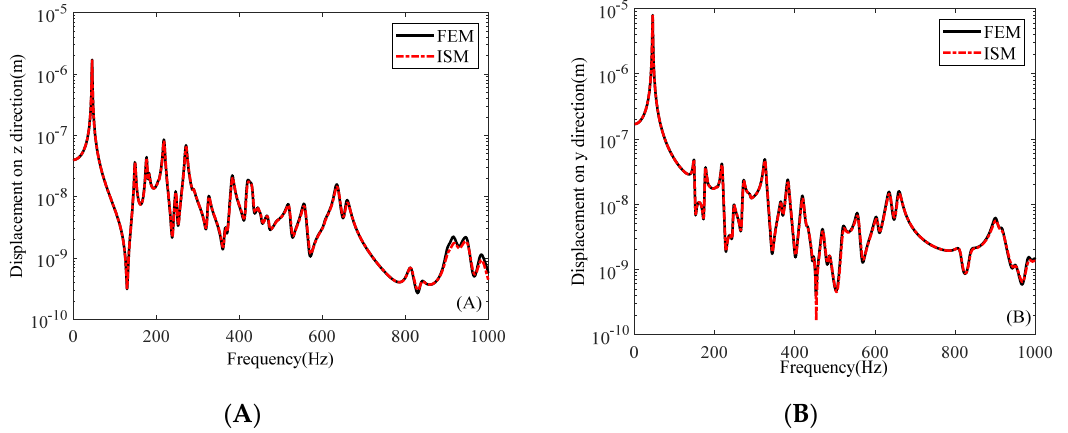
Figure 7. Dynamic responses of point P2 compared with FEM: ( A ) in z direction, ( B ) in y direction.